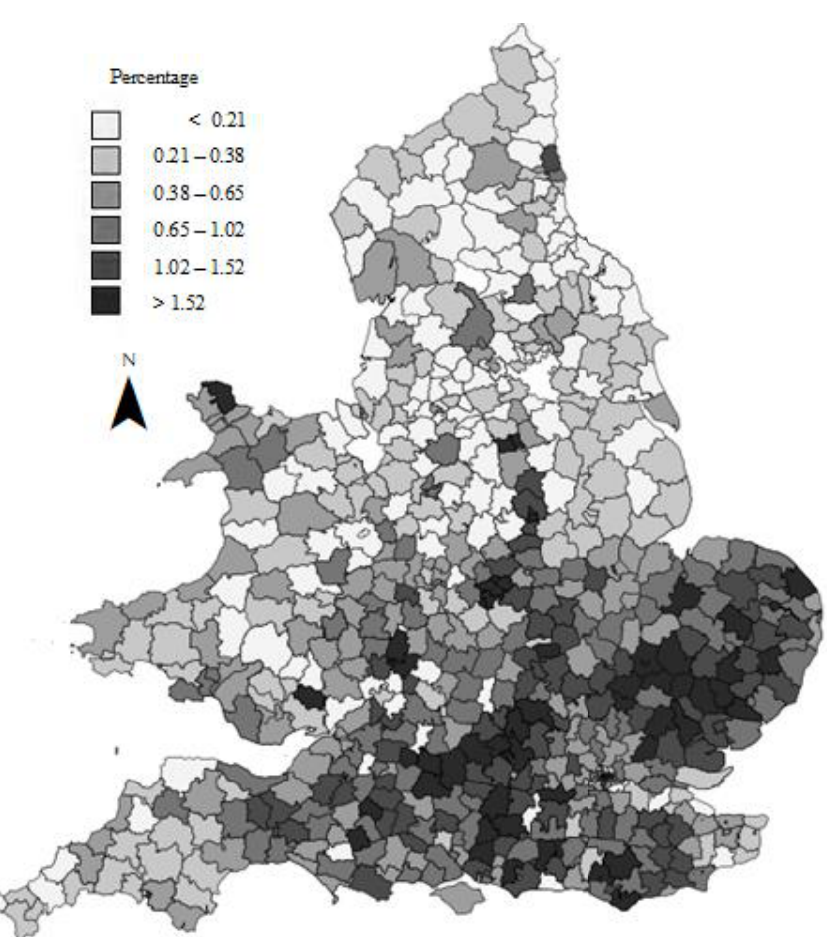
Figure 3. Able-bodied males on poor relief on 1 July 1861 for England and Wales, from the Poor Law board returns to Parliament, as a percentage of all males aged 15 to 64, as recorded by the 1861 Census of Population.